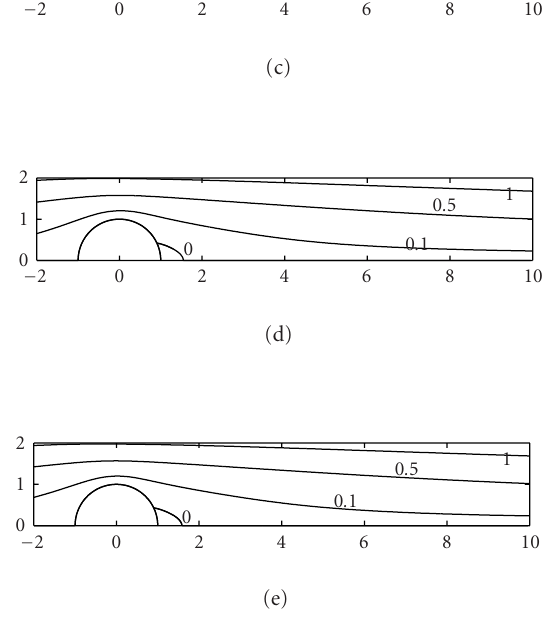
Figure 4.2 . Streamlines for Re = 20. (a) N = 0, (b) N = 1, (c) N = 3, (d) N = 10, and (e) N =